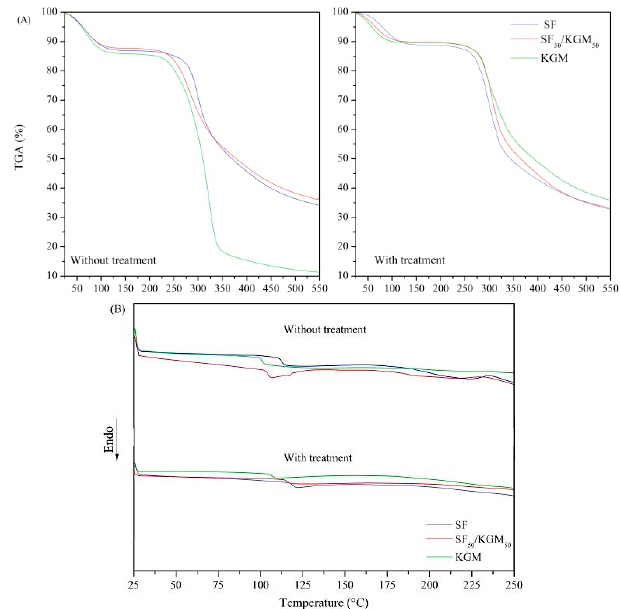
Figure 5. ( A ) TGA and ( B ) DSC analysis of beads.